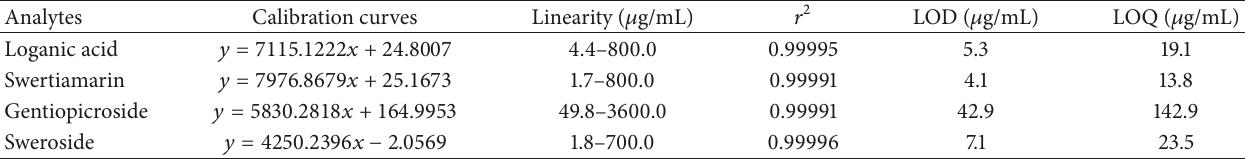
Table 1: The calibration curves, 𝑟 2 , LOD, and LOQ of the standard